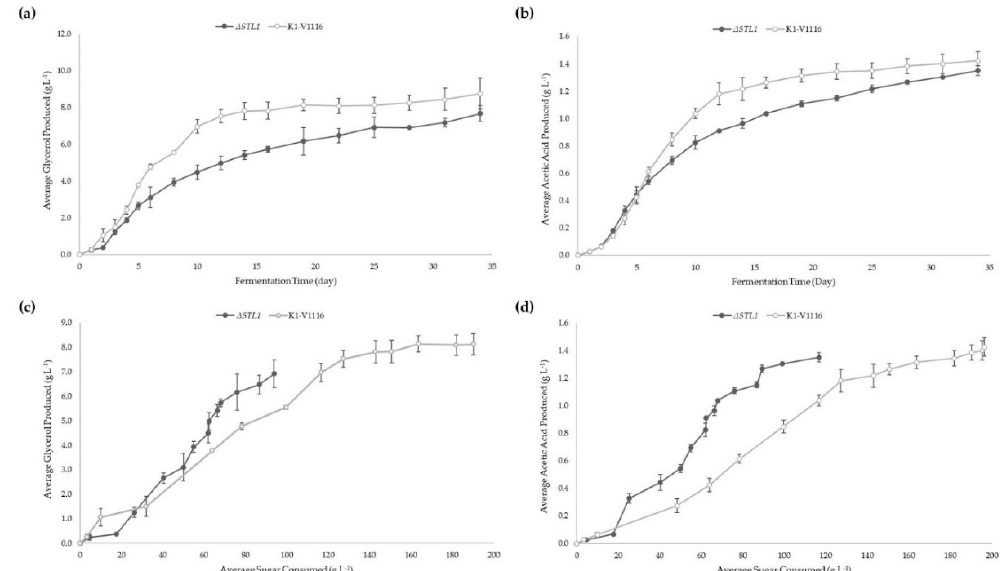
Figure 8. Average glycerol produced ( a ) and average acetic acid produced ( b ) over the time course of the fermentation. Average glycerol produced ( c ) and average acetic acid produced ( d ) versus sugar consumed over the course of the fermentation. Includes K1-V1116 ∆ STL1 ( ● ) and K1-V1116 ( ○ ). Values are the averages of triplicate fermentations, with each sample tested in duplicate for metabolite analysis.